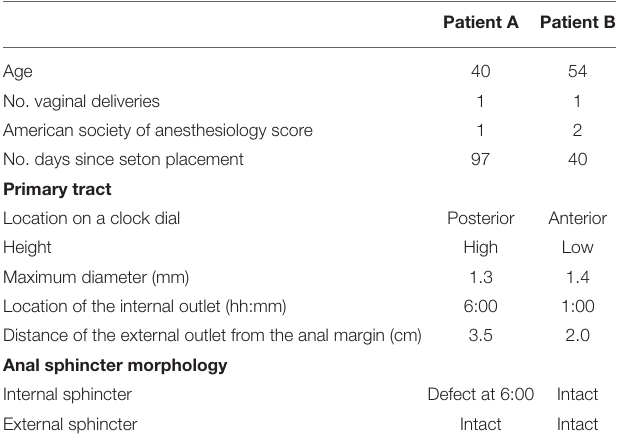
TABLE 1 | Patients and fistula characteristics. TABLE 2 | Secondary